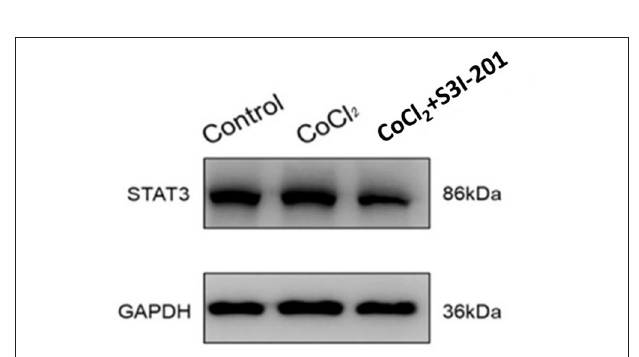
FIGURE 4 | Western blot showing the expression of STAT3 in retinal cells treated with 250 µ mol/L CoCl 2 and S3I-201.